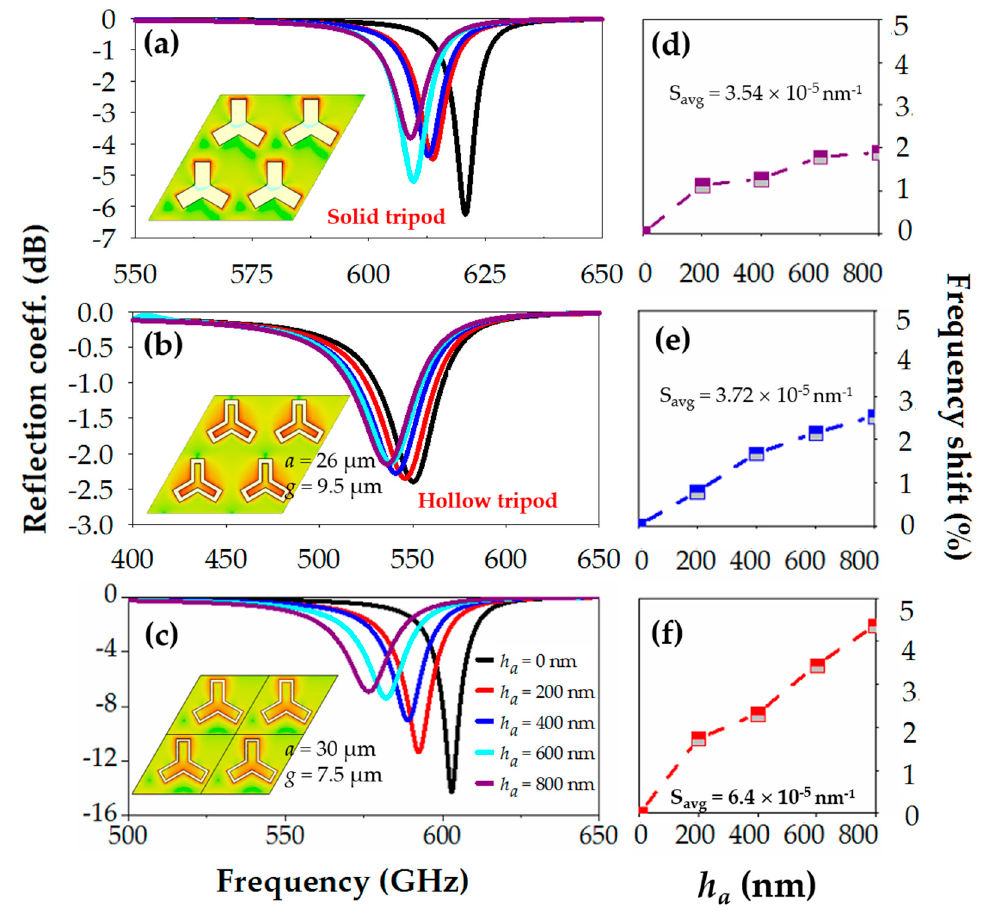
Figure 2. Reflection coefficient for different analyte thicknesses: 0 nm (black line), 200 nm (red line), 400 nm (blue line), 600 nm (cyan line), and 800 nm (dark pink line), for the solid tripod structure ( a ), and the hollow tripod structures ( b , c ). Insets: electric field magnitude over the empty (analyte-free) tripod metasurfaces. Frequency shift as a function of the analyte thickness, for extremely thin analytes with average sensitivity for the solid tripod structure ( d ), and the hollow tripod structures ( e , f ).